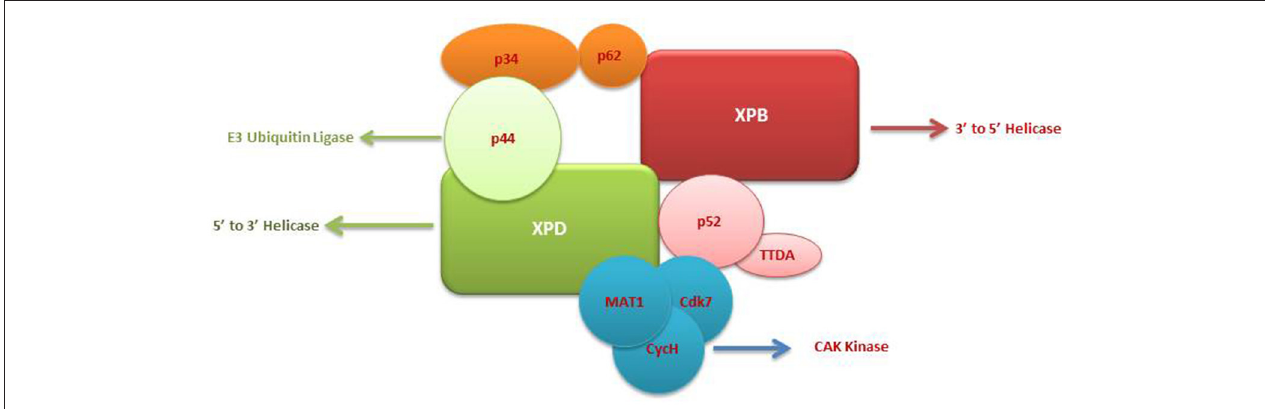
FIGURE 1 | A multisubunit functional complex of TFIIH. The TFIIH complex is composed of eleven subunits, with XPB making its one face and XPD another. The complex also contains CAK kinase domain of three subunits (Blue). Functonally TFIIH possess four enzymatic activities; XPB and XPD has helicase activity, Cdk7 has kinase and p44 serves as E3 ubiquitin